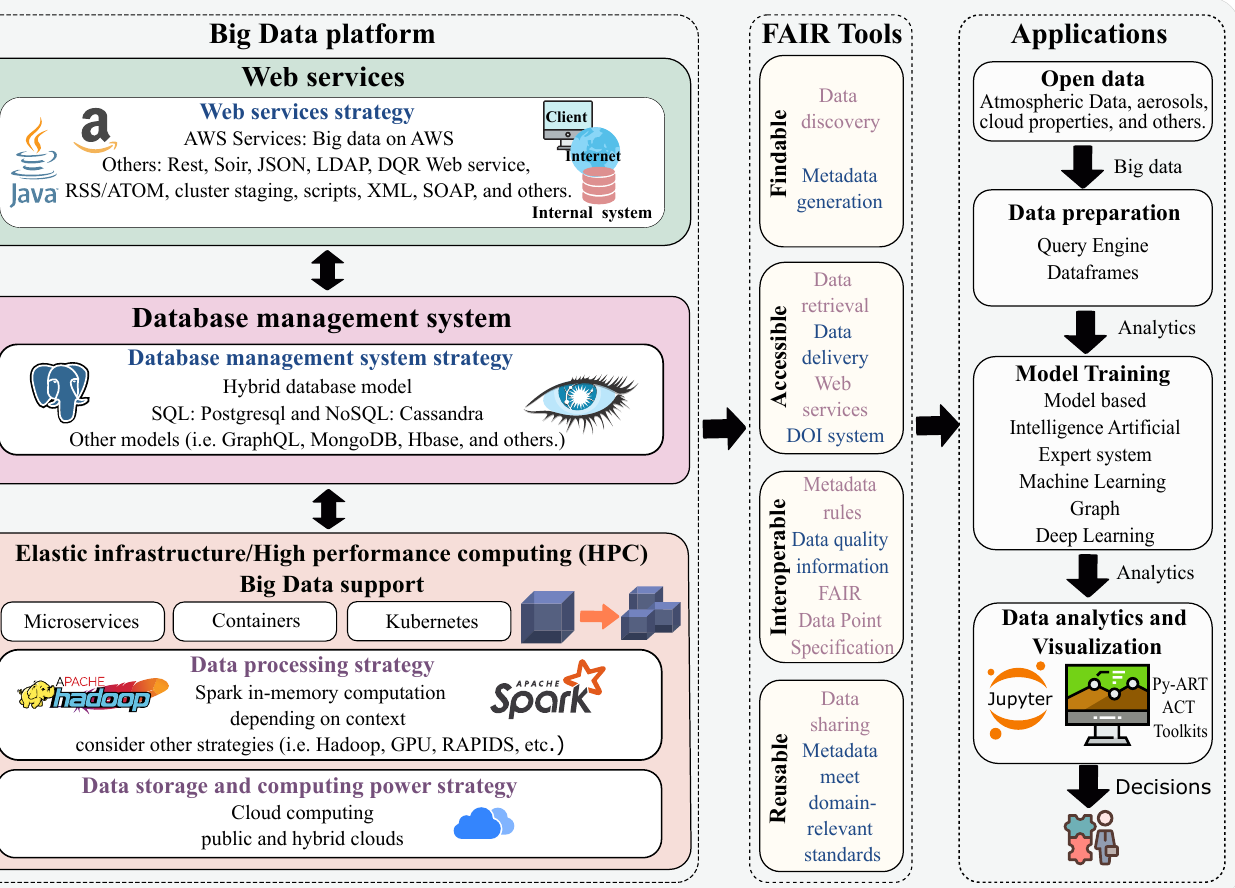
Figure 4. Overall view of the architecture of the data